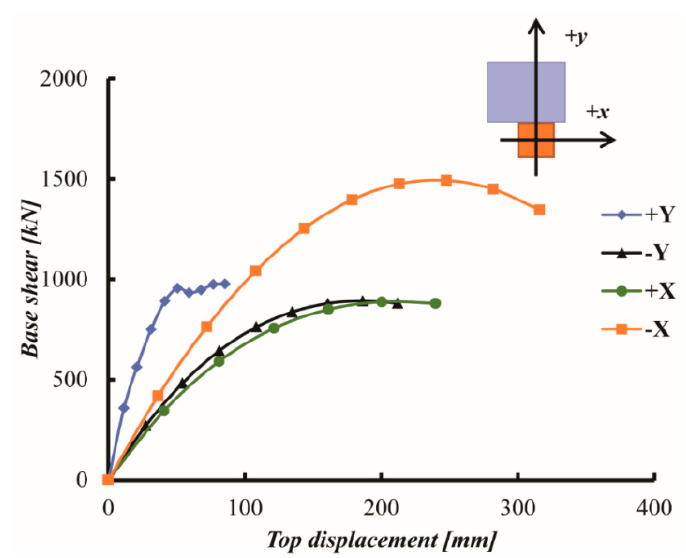
Figure 10. Capacity curves from pushover analysis (total weight of the tower equal to 8904 kN).